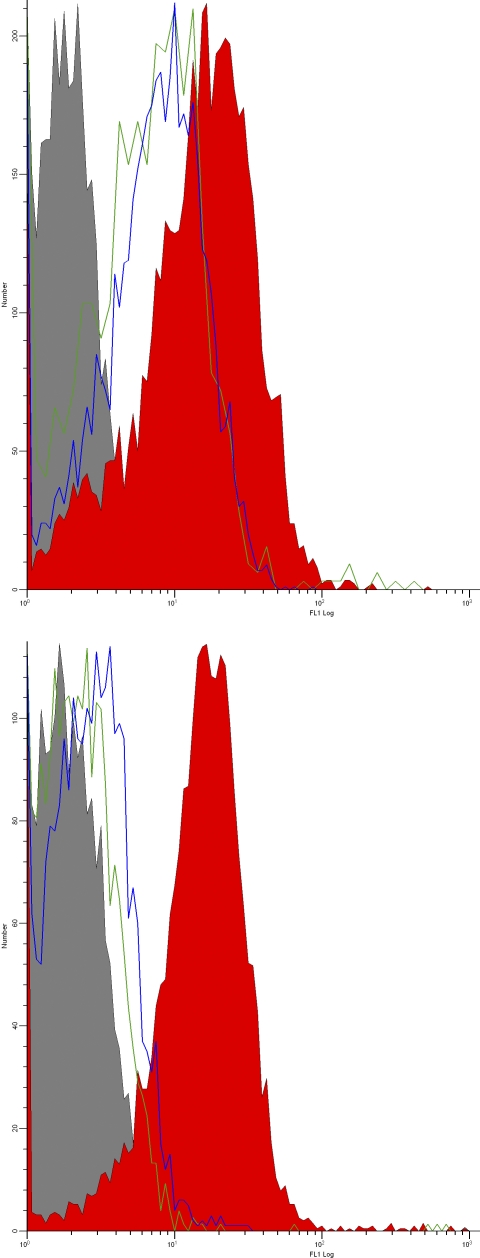
Surface Reactivity (Fitch FL1) of Rabbit Antibodies Targeting Conserved VAR2CSA RegionsRabbit antibodies were affinity purified on peptides (P62 and P63; see Figure 5 for details) and tested for reactivity with IE expressing VAR2CSA. The parasite lines FCR3CSA (A) and 3D7CSA (B) IE were used. The following antibodies were used: grey, IgG control; red, VAR2CSA-specific rabbit pool; blue, P63 (DBL5)-specific antibodies; green, P62 (DBL3)-specific antibodies. For FCR3, the number of cells staining positive with the VAR2CSA pool, P63 and P62 were 97%, 56%, and 48%, respectively. For 3D7, 85%, 7%, and 6% of the cells were positive.